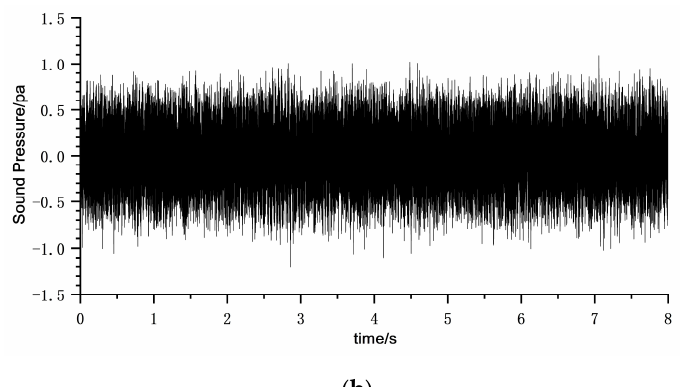
Figure 14. Time course of sound pressure before and after placing the model at the wind speed of 30 m/s. ( a ) 30 m/s wind tunnel sound pressure time course without model; ( b ) 30 m/s wind tunnel sound pressure time course with model.